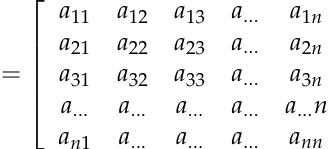
Table 2. Saaty’s 1 ‒ 9 scale of the relative importance [31,74].